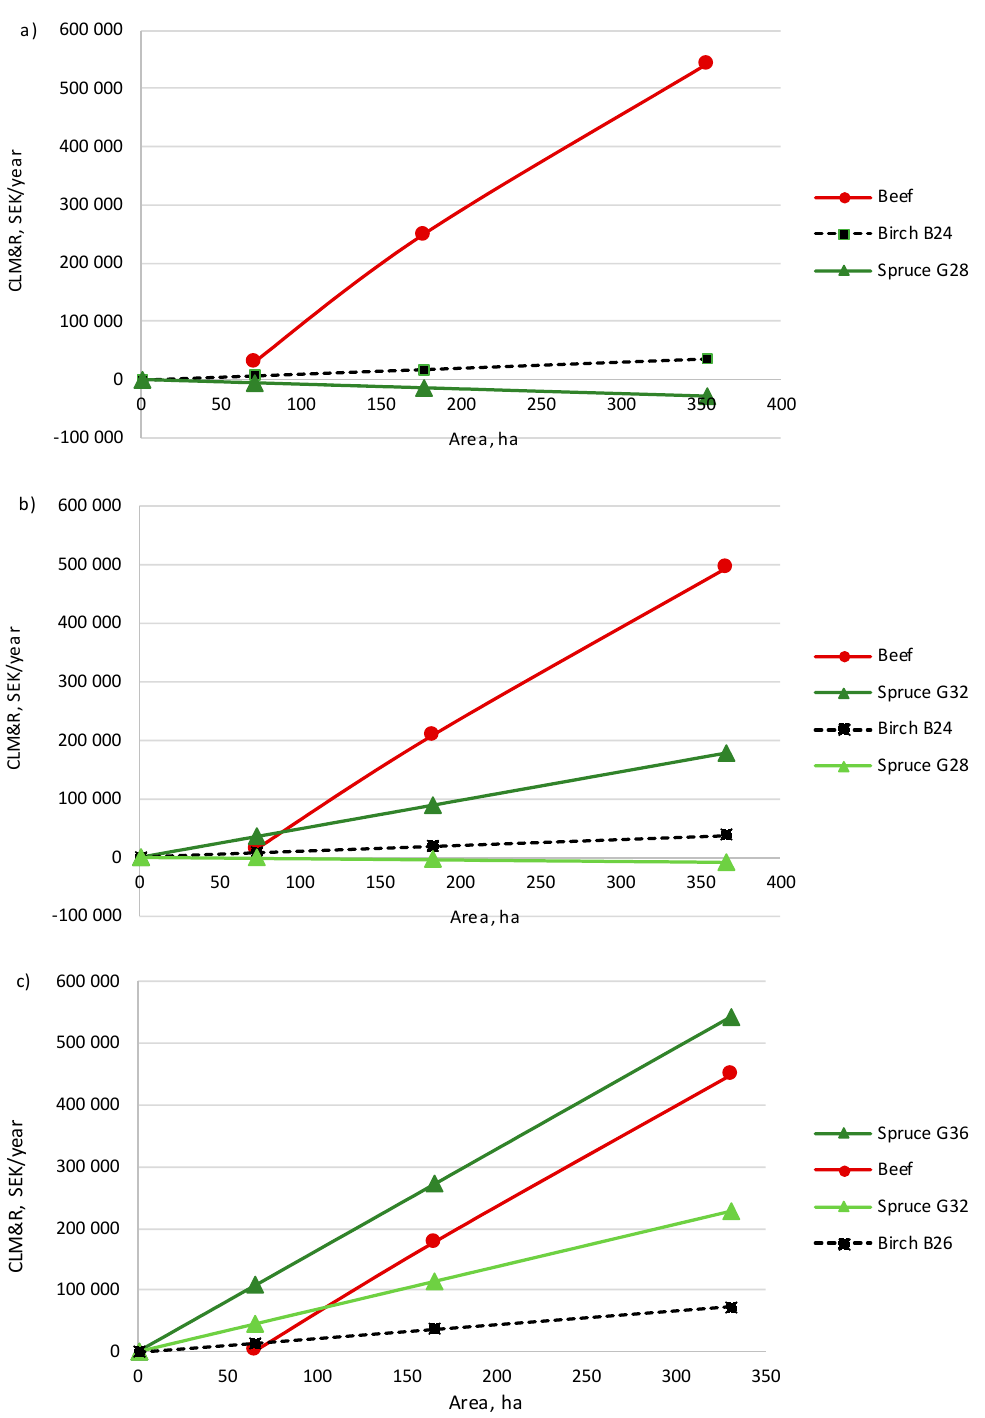
Figure 6. Contribution to land, management, and risk (CLM&R) for spruce plantation and natural regeneration of birch on different SQCs and organic suckler cow-based beef production according to basic calculations in northern ( a ), central ( b ), and southern ( c ) Sweden. The points mark the area of semi-natural pasture plus arable land required for herds with 20, 50, and 100 cows+, that is beef suckler cows + rearing of all their calves for slaughter and replacement.